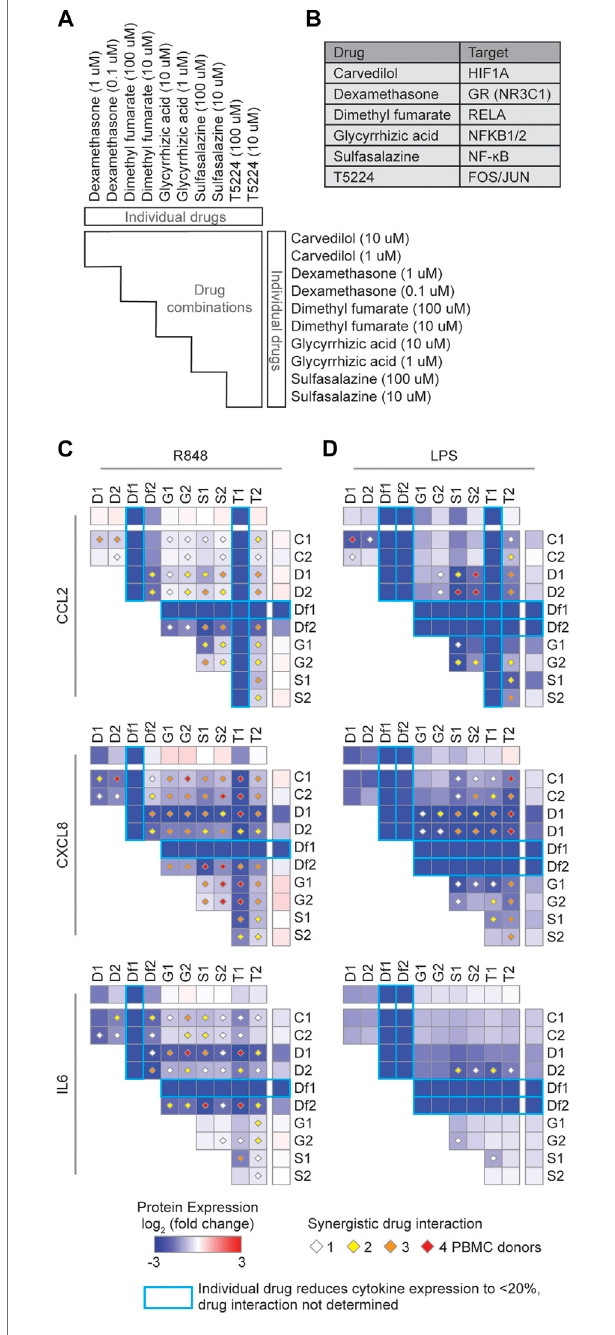
FIGURE 2 | Identi fi cation of synergistic drug combinations targeting TF hubs that regulate in fl ammatory cytokines. (A) Schematic of experimental design to test 60 drug combinations. (B) Drug TF targets. (C,D) Heatmaps showing the average log 2 (fold change) cytokine production across four PBMC donors treated with the indicated drugs, relative to PBMCs not treated with the indicated drugs, and stimulated with (C) R848 or (D) LPS. Diamonds indicate synergistic drug interactions, as determined by the coef fi cient of drug interaction, observed in 1 (white), 2 (yellow), 3 (orange), or all 4 (red) PBMC donors. Blue boxes represent cases wherein the individual drug reduced cytokine expression to less than 20%, and therefore synergistic effects were not